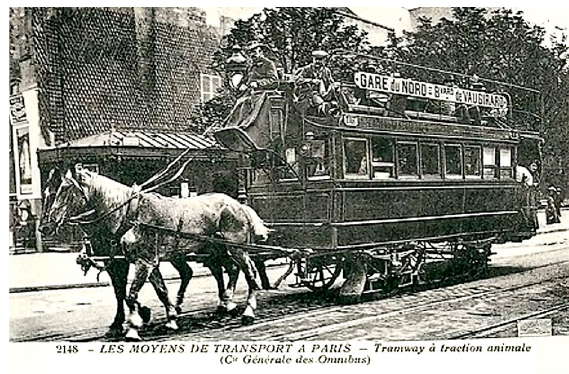
Fig. 5. The konkė at the Cathedral